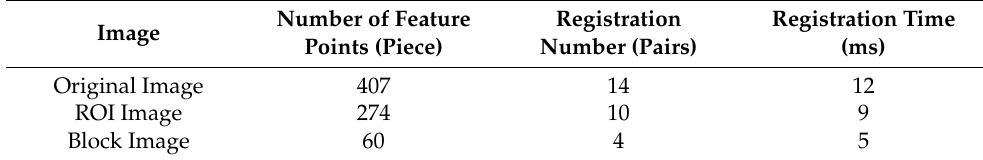
Figure 14. Random sample consensus (RANSAC) matching of feature points. ( a ) Figure 13(a5) and Figure 13(b5) registration. ( b ) Figure 13(a6) and Figure 13(b6) registration. ( c ) Figure 13(a7) and Figure 13(b7) registration. ( d ) Figure 13(a8) and Figure 13(b8) registration. Table 4. Comparison of the